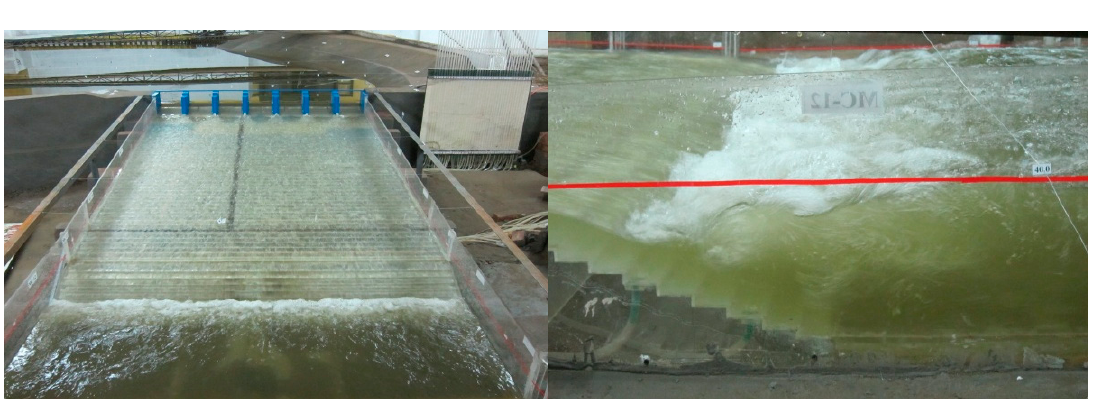
Figure 14. Steady flow and hydraulic jump when Z up = 55.86 m in the design case [16].